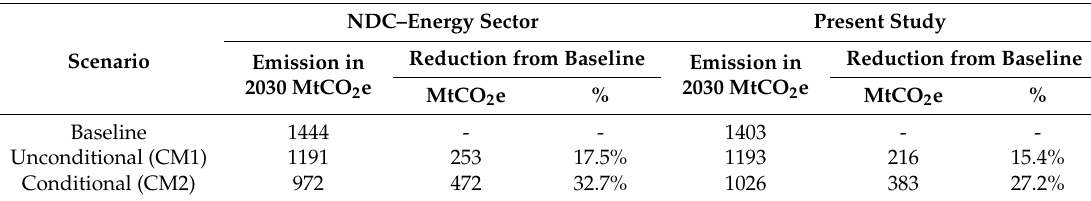
Table 3. Comparison of Indonesia’s sectoral breakdown with Indonesia’s Nationally Determined Contribution